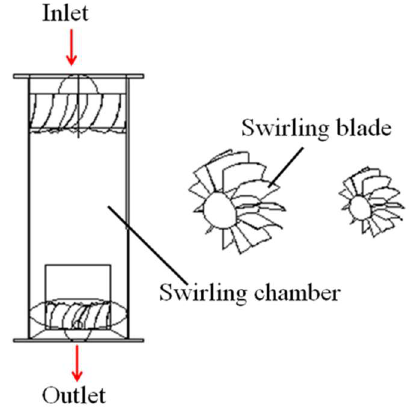
Figure 4. Dust suppression process in a swirling chamber.